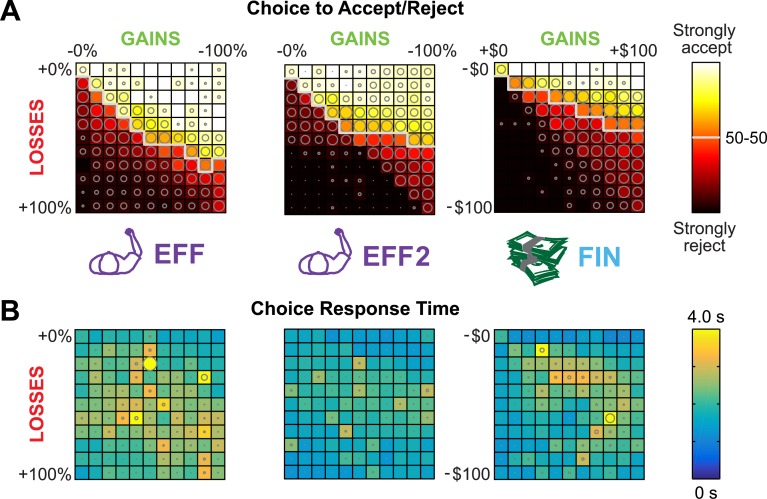
Example decision matrices.(A) Average frequency of accepting and rejecting lotteries across gains and losses and (B) average response times to the first accept/reject decision for the initial effort task (left), the repeated effort task (middle), and an equivalent financial task (right). Sizes of the overlaid circles represent the within-lottery standard deviation, plotted relative to the maximum SD across tasks (for frequency, SDmax = 0.51 from FIN; for response time, SDmax = 23.1 s from EFF). Gray line in frequency matrices denotes the 50% accept/reject boundary, above which subjects accepted more often and below which they rejected more often.